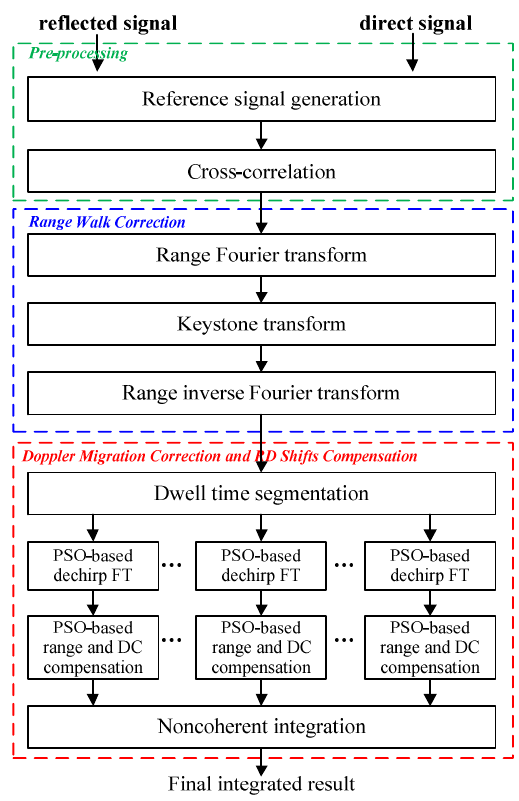
Figure 3. Proposed integration method flowchart.